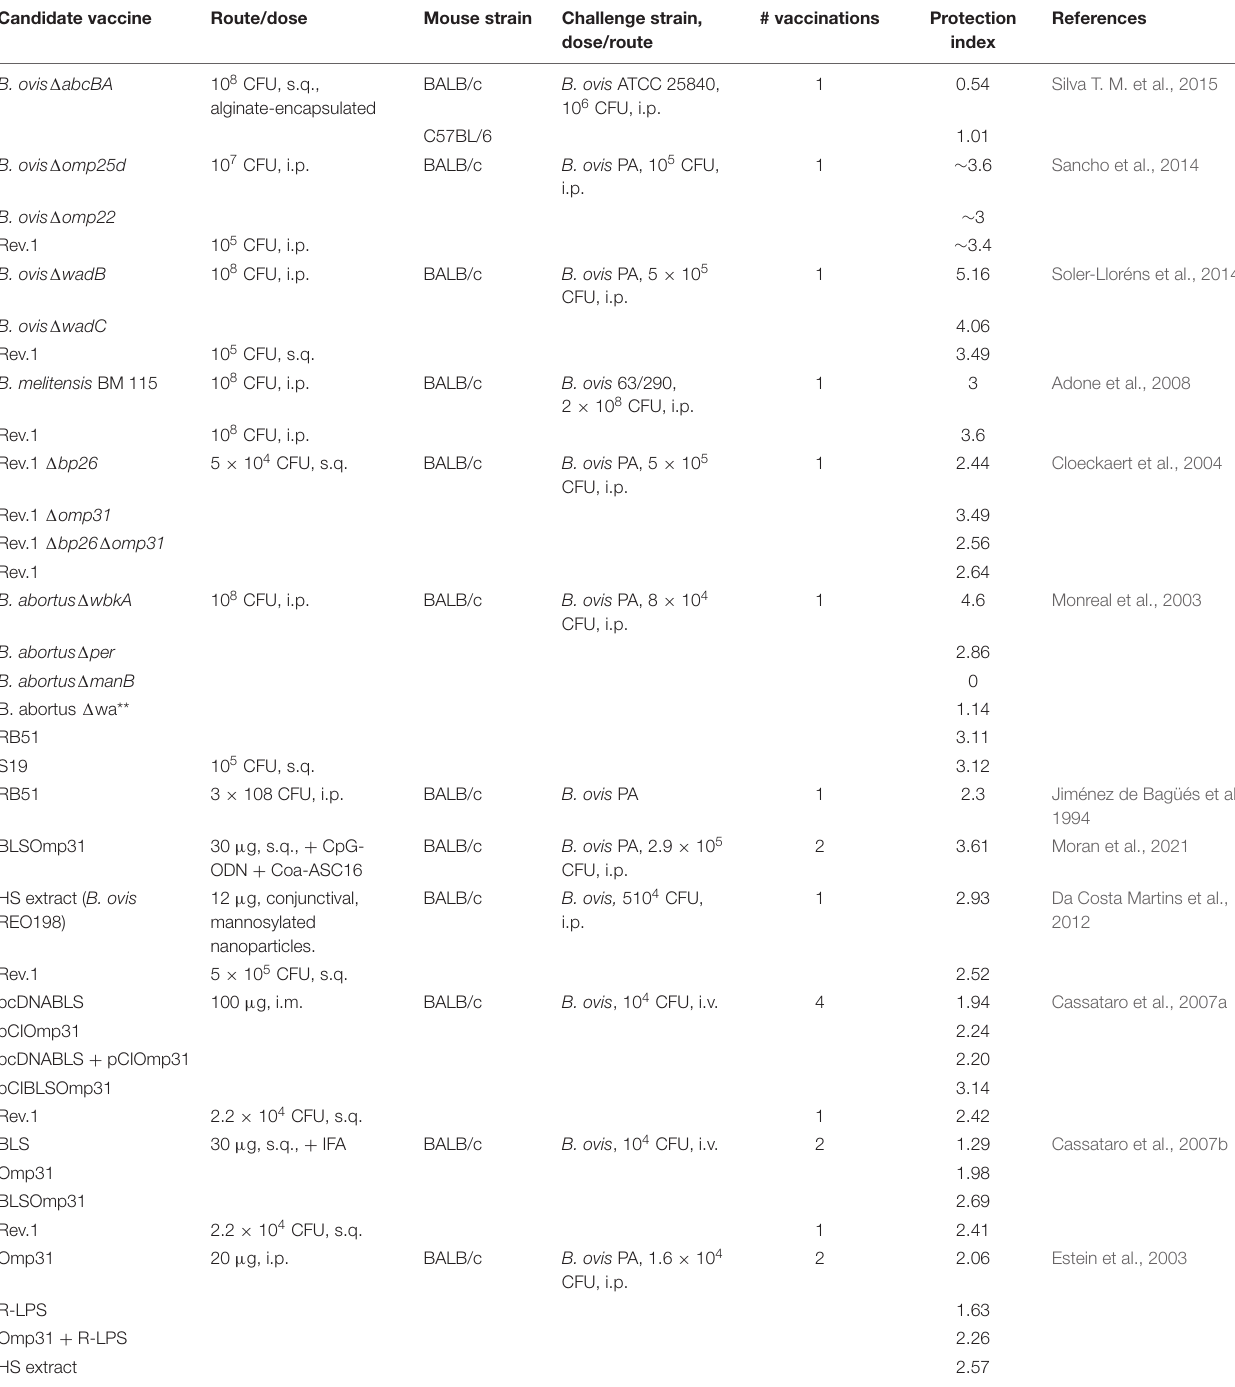
TABLE 2 | Vaccine candidates against B. ovis investigated in the mouse model in select